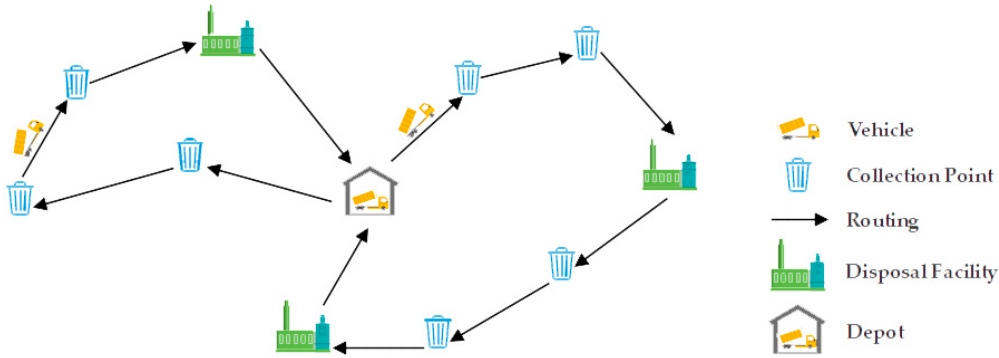
Figure 1. Simplified routing diagram of municipal solid waste (MSW) collection.